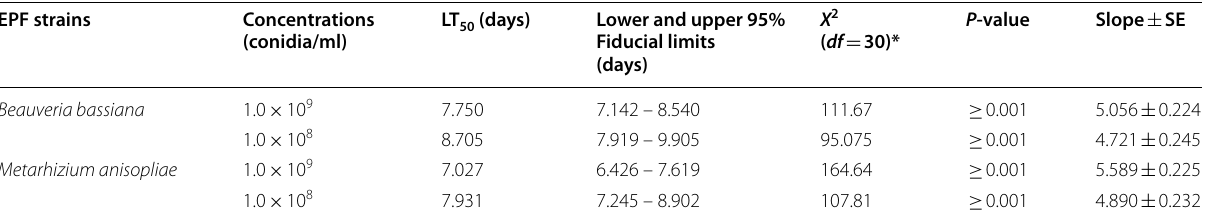
Table 5 Median lethal time (LT ) values for the indigenous strains of entomopathogenic fungi Beauveria bassiana and Metarhizium 50 anisopliae bioassayed against 3rd instar larvae of fall armyworm Spodoptera frugiperda under laboratory conditions